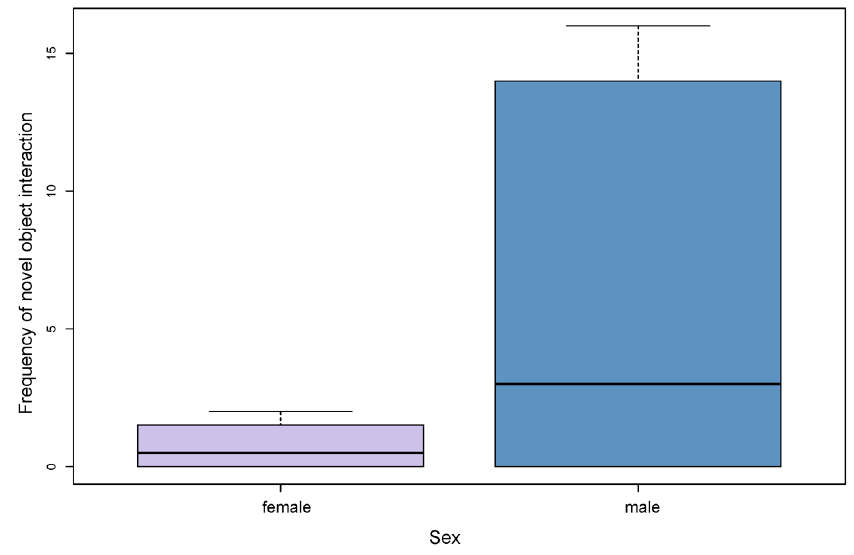
Figure 5. Influence of sex on frequency of novel object interaction.